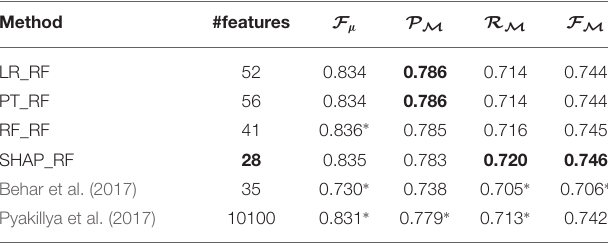
TABLE 4 | Results of heart rhythm classification by using ranked features and RF as the underlying classifier. Method